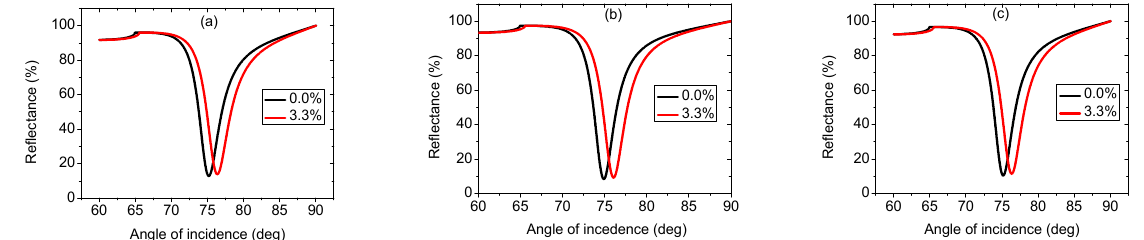
Figure 6. Reflectance curves of the structure prism/Ag/Si/Ti 3 C 2 T x /analyte medium for different values of the damping rate. ( a ) γ = 11.7809 × 10 − 13 rad/s, ( b ) γ = 10.7040 × 10 − 13 rad/s, and ( c ) γ = 9.8072 × 10 − 13 rad/s.